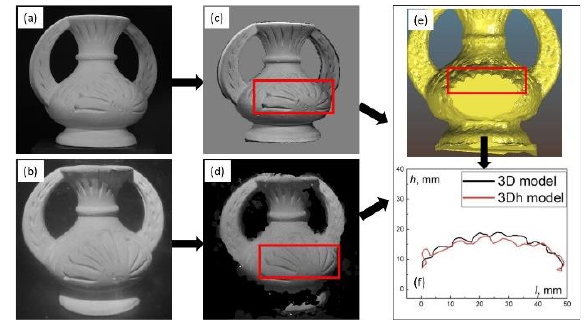
Figure 10. Photographs of the object (a) and its image, recon- structed from the reflective type of hologram (b). Front views of 3D (c) and the 3Dh (d) models. The highlighted in red areas of front views (c) and (d) show the fragments along which the surface profiles were plotted. Relief area of object for constructing cross-sections (e), and surface profile plot for both 3D and 3Dh models